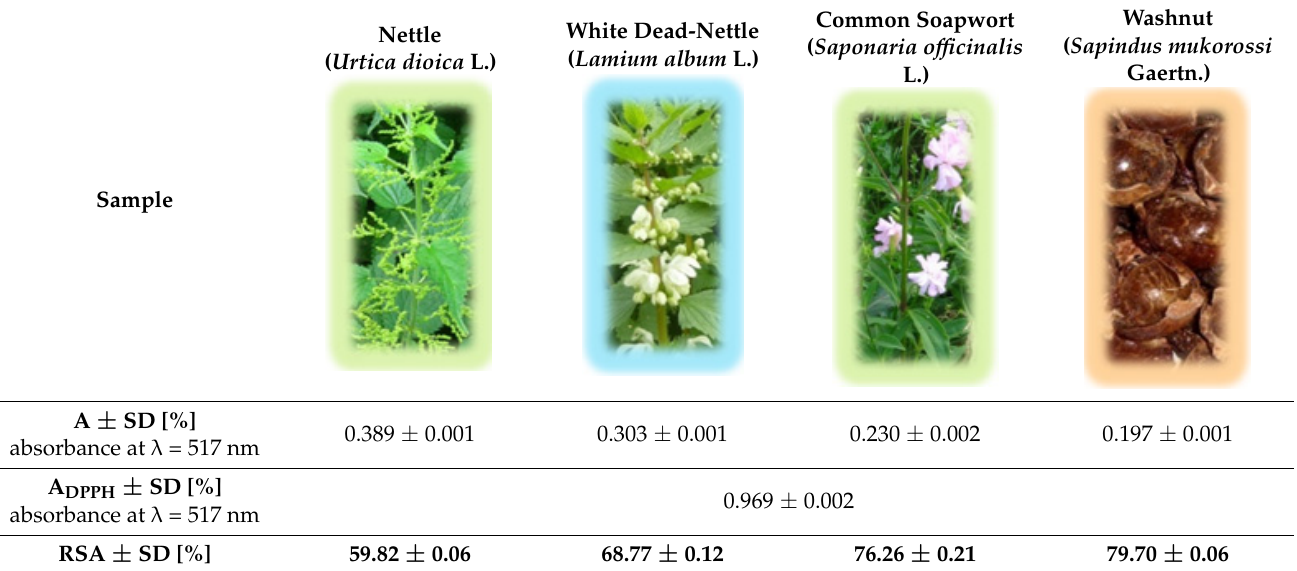
Table 1. Total antioxidant activity after 15 min of an inhibition time.